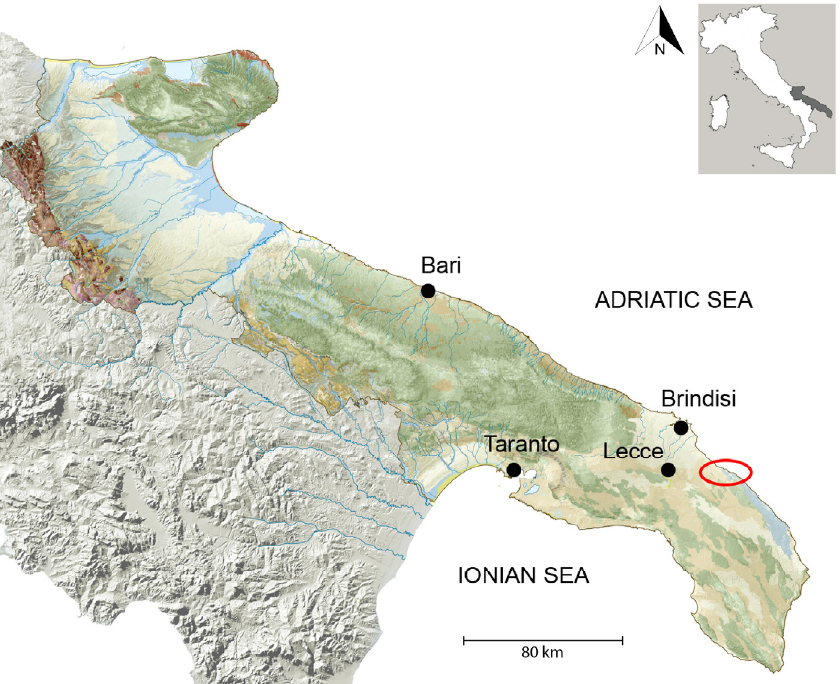
Figure 1. Shaded relief of Apulia, southern Italy, showing the location of the Acquatina di Frigole lagoon (red ellipse) in the Salento peninsula.